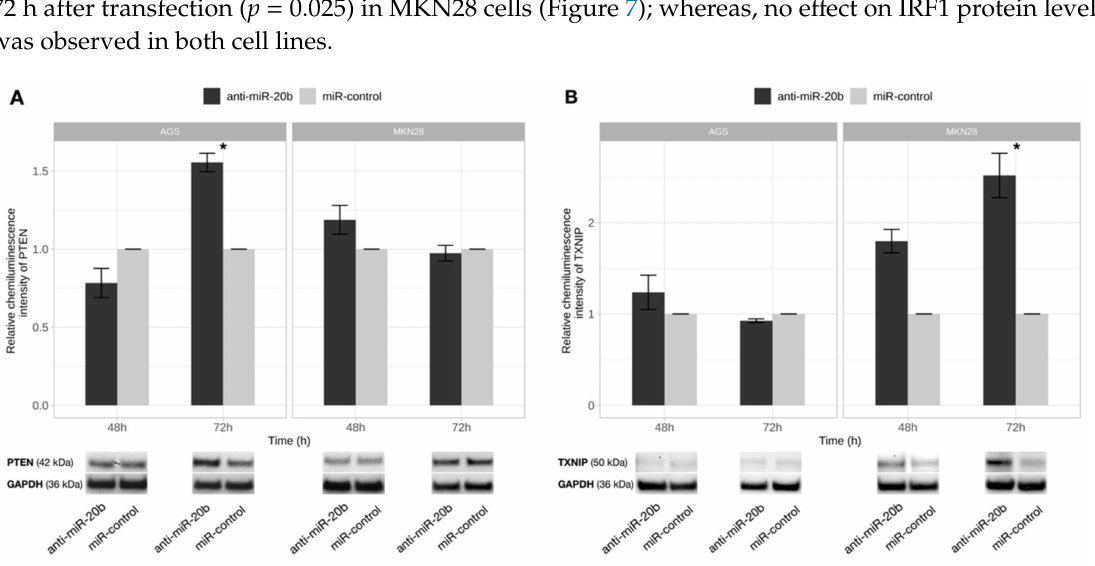
Figure 7. PTEN and TXNIP proteins level changes after exogenous miR-20b expression inhibition. PTEN ( A ) and TXNIP ( B ) protein expression comparison 48 h and 72 h after transfection in AGS and MKN28 cell cultures transfected with anti-miR-20b and miR-control. Significant PTEN protein level increase was determined 72 h after transfection in AGS cell culture and TXNIP- 72 h after transfection in MKN28 cell culture. Representative pictures of PTEN and TXNIP proteins signals detected by Western Blot presented at the bottom of a figure (* p < 0.05). Data from four independent